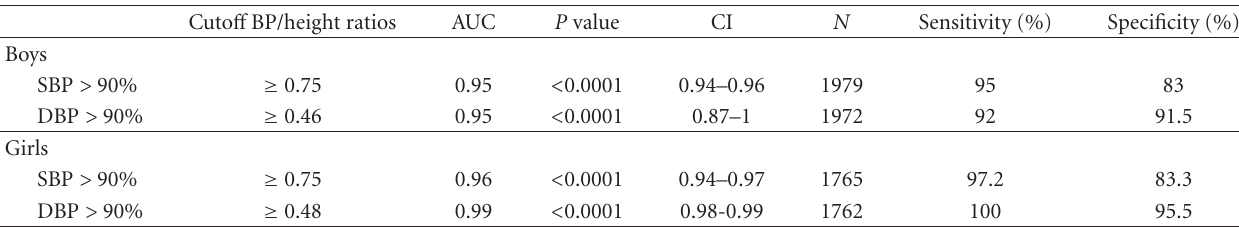
Table 1: ROC analysis of SBP and DBP in boys and girls. Area under the curve (AUC) and corresponding P values are depicted with the associated confidence intervals for the calculated cuto ff values of the BP/height ratios greater than 90th percentile. Correlation of the BP/height ratios with their respective BP for each cuto ff value is quantified by sensitivity and specificity